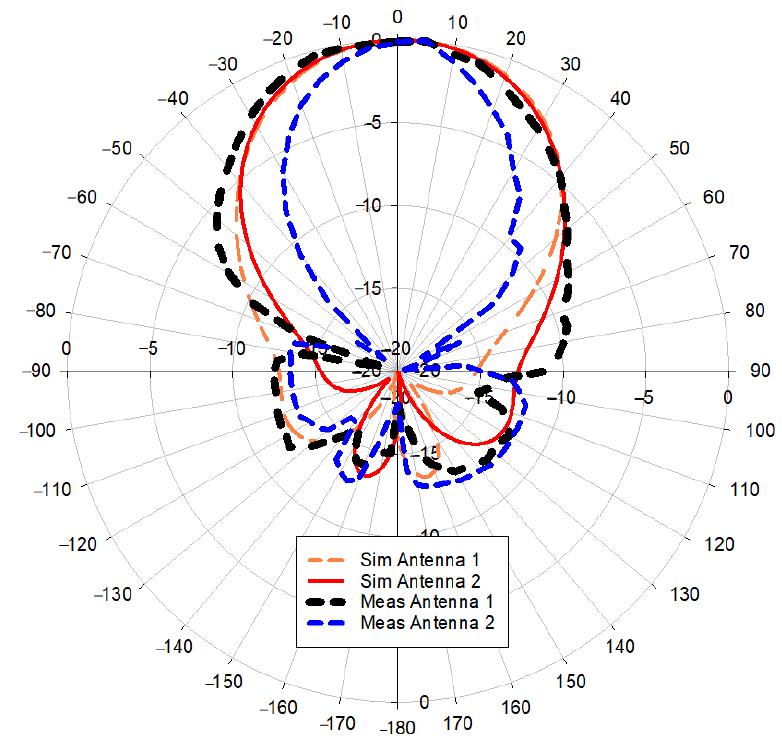
Figure 14. The polar radiation pattern results for MIMO-RIS-EBG.